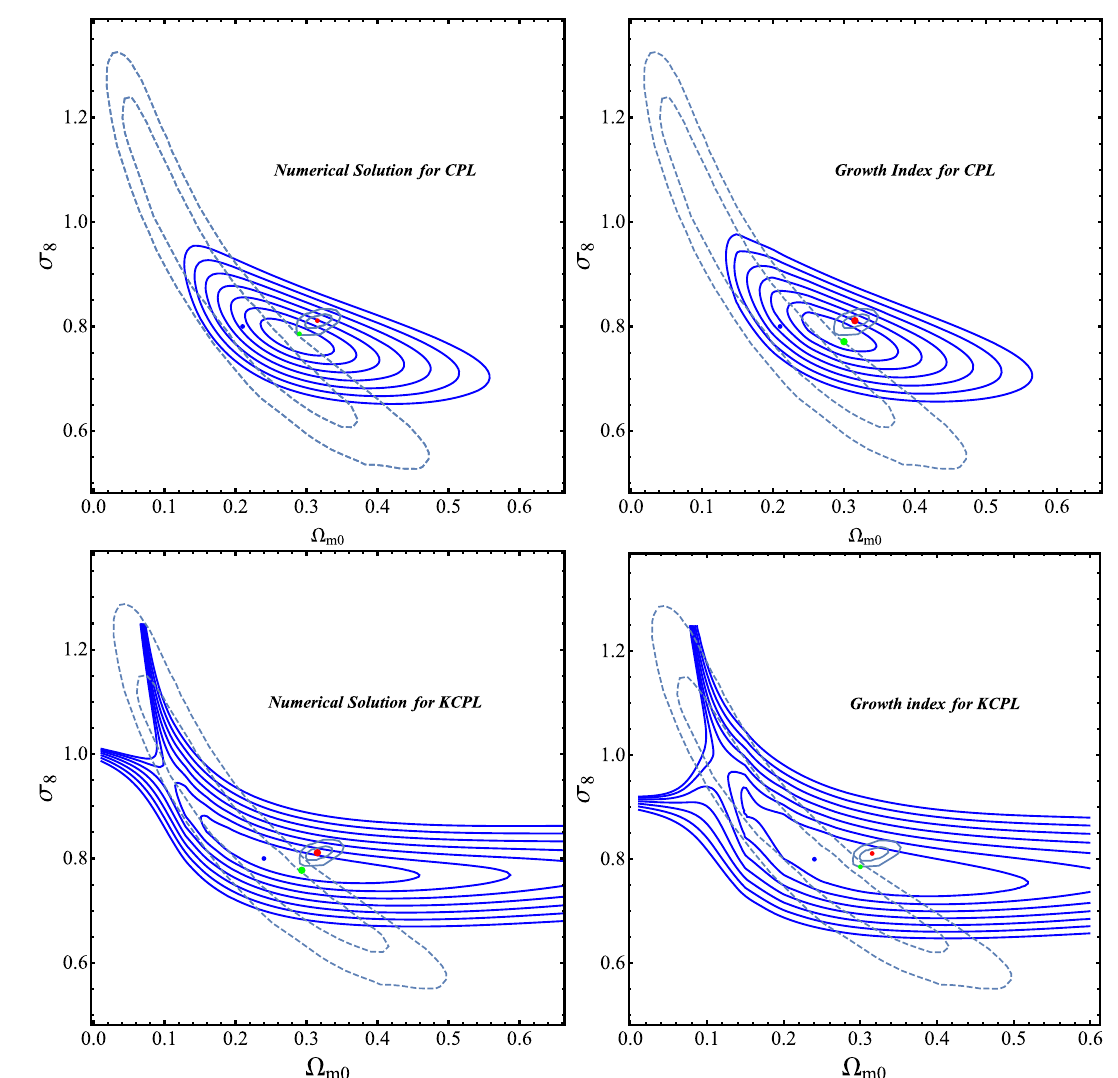
Fig. 2 In the top, we can see observational constraints on the flat w w a CDM model. In the bottom, we see the observational constraints 0 on the non-flat w 0 w a CDM model. The (cid:3) k 0 parameter was marginal-